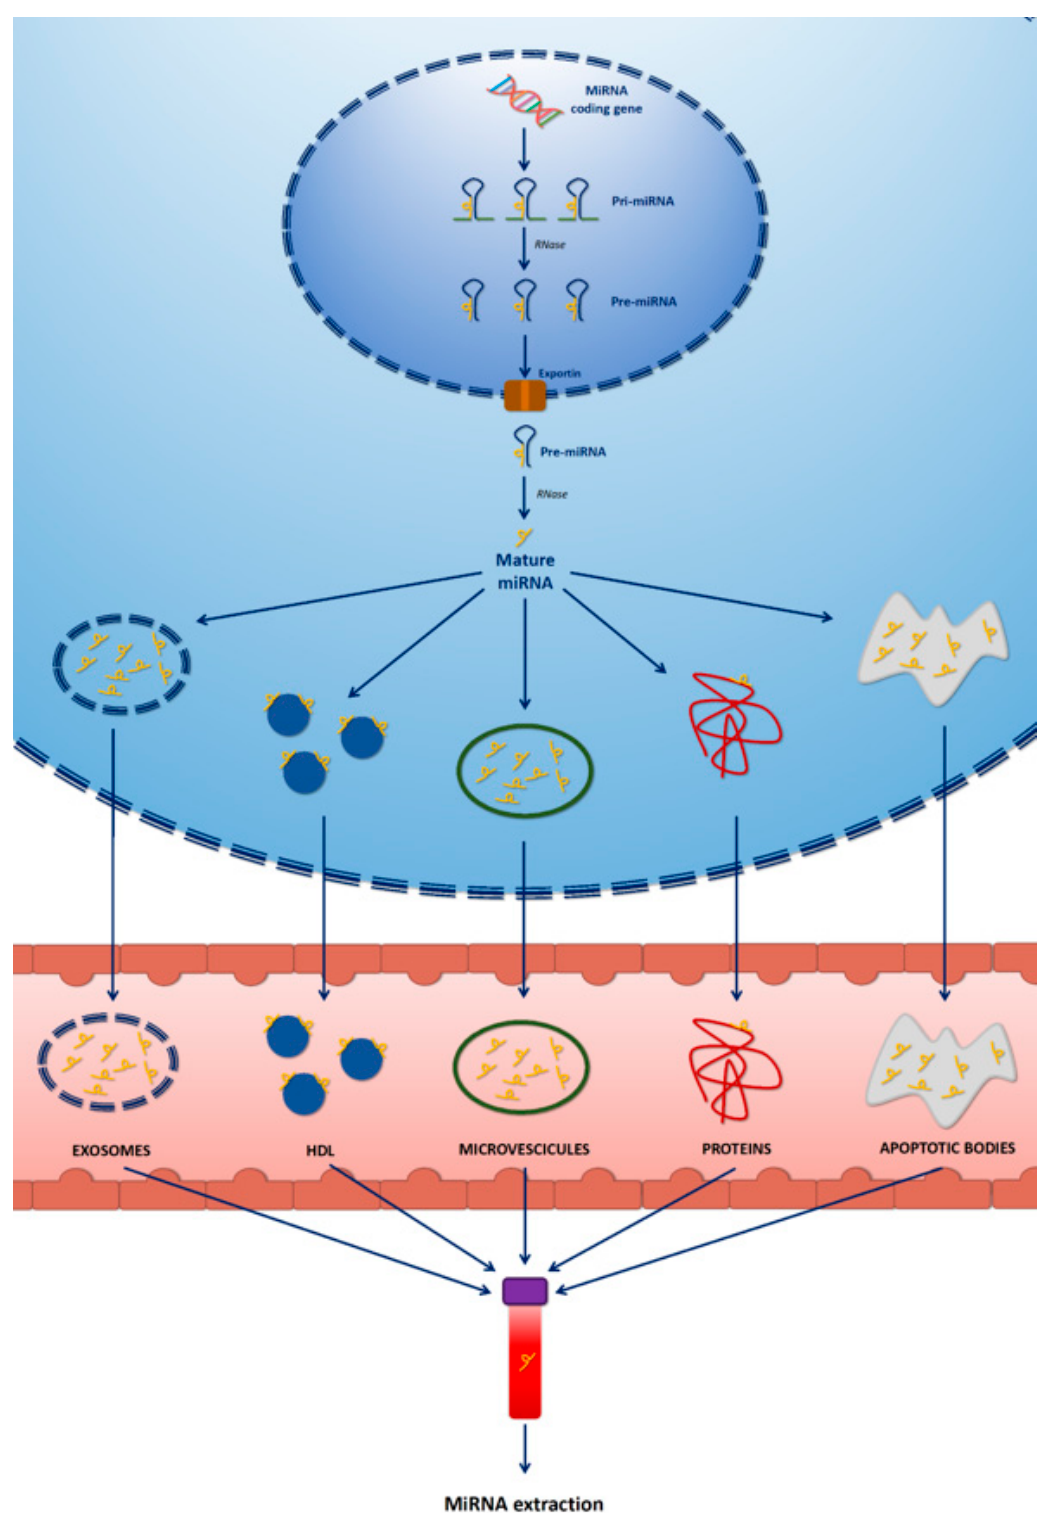
Figure 3. Secretion of miRNAS from nucleus to extracellular spaces and circulatory system. Pre-miRNA and mature miRNAs are secreted from the either in micro particle free form bound with proteins or in encapsulated macrovesicles. There are five main modes by which miRNAs are secreted into extracellular spaces and circulatory system (exosomes, HDL, microvescicules, protein-bound, and apoptotic bodies).